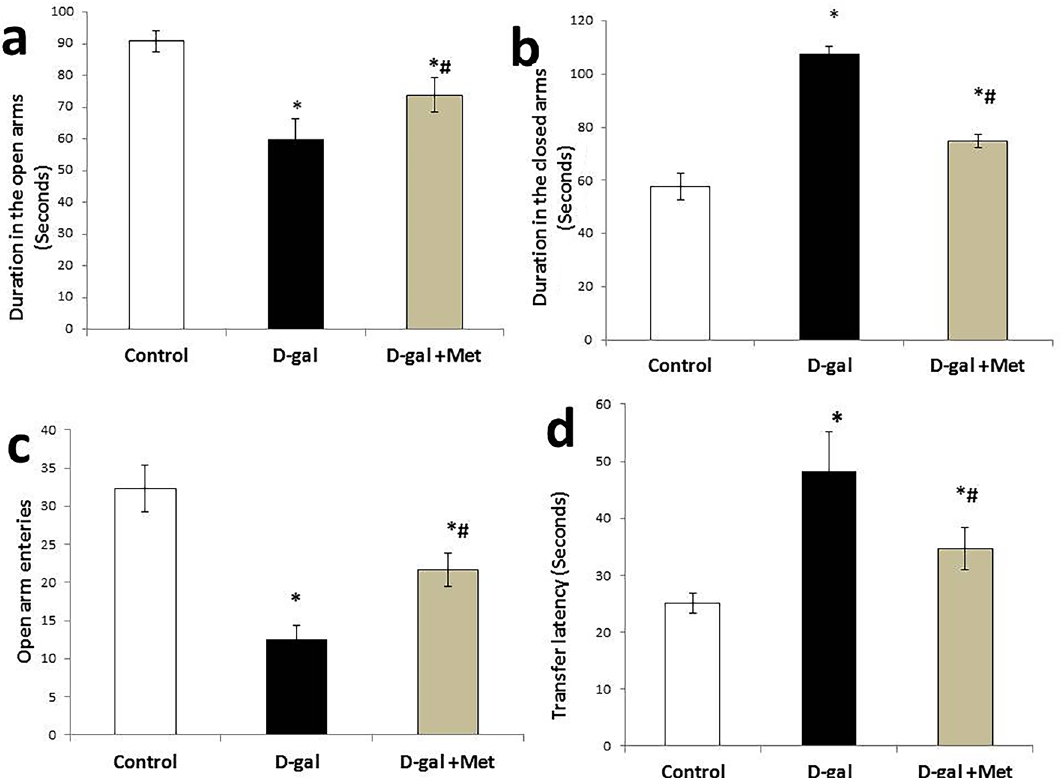
Figure 3. Effect of metformin on anxiety-like behavior in D-galactose-induced aging rat model in EPM test (*significant when compared to control group, # significant when compared to D-gal group). Data are shown as means + SD (n = 10). ANOVA was used to make group comparisons; Significance = P <